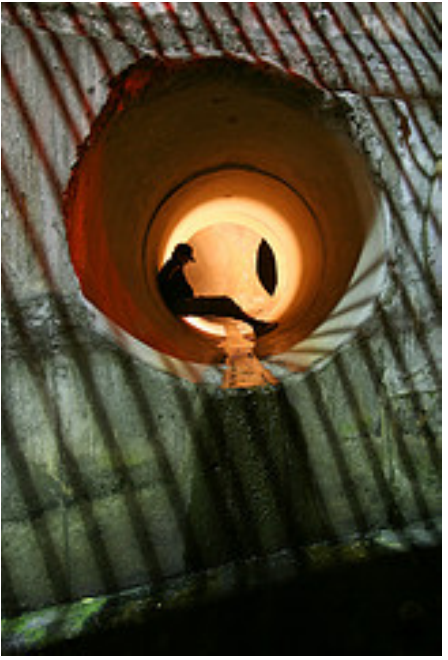
Figure 10: ‘Gatecrashed Drain’ by Mr Magoo ICU